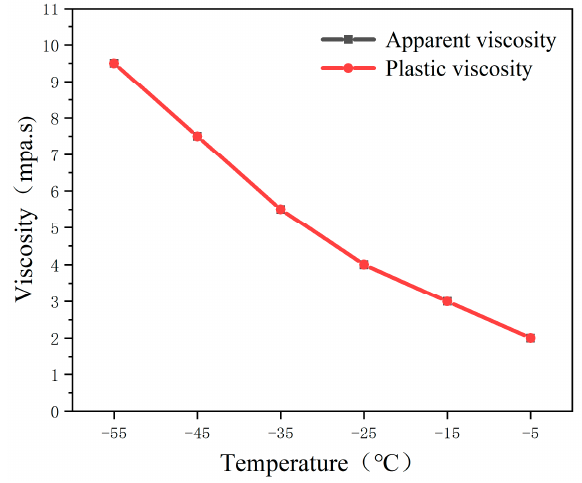
Figure 1. Influence of temperature on the viscosity of drilling fluid.